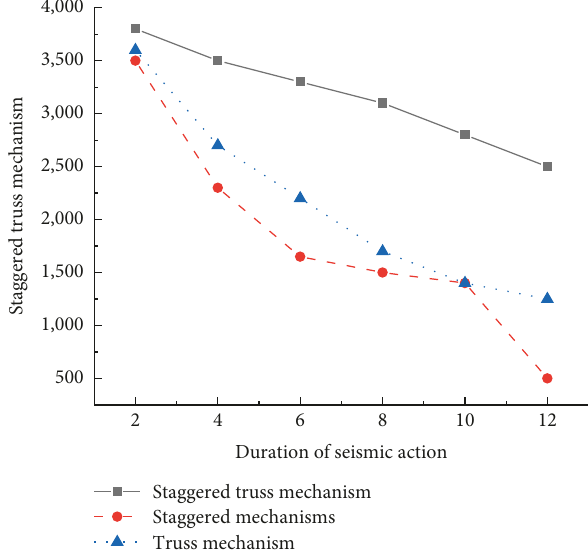
Figure 8: Stress changes of building columns with different